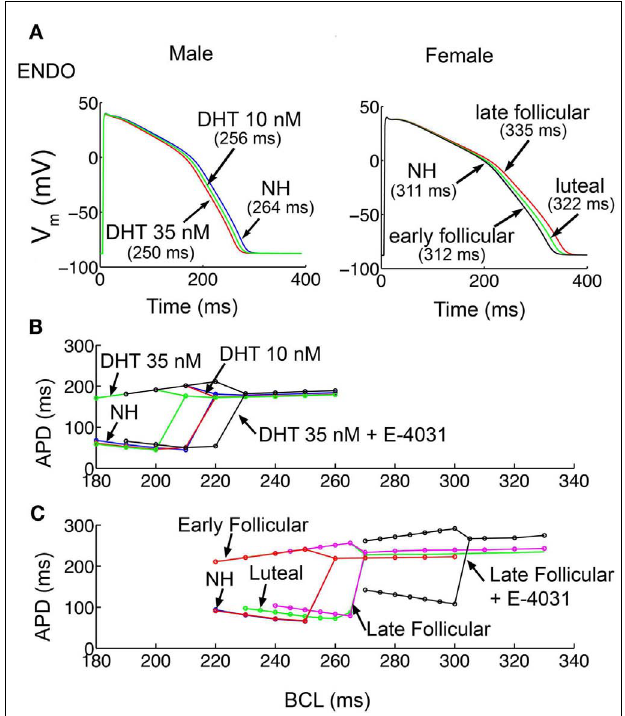
FIGURE 2 | Simulated action potentials duration (APD) andAPD alternans. (A) APD for the 1000th paced beat at a cycle length of 1000ms in single endocardial cells. APDs with no hormone (NH;Table S1 the Methods in Supplementary Material) and two physiological concentrations of DHT (10 and 35nM) in male cells are shown in left. Estradiol and progesterone at different physiological concentrations corresponding to three stages of the menstrual cycle were added in female cells (right). (B) Male epicardial cells with DHT treatment developed alternans at fast pacing rates, between cycle lengths 180 and 210ms. (C) In female epicardial cells alternans developed at a much slower basic cycle length during the late follicular phase (pink) compared to luteal (green) and early follicular (red). I Kr block increased susceptibility to alternans development in male (black in B ) and dramatically in female models (black in C